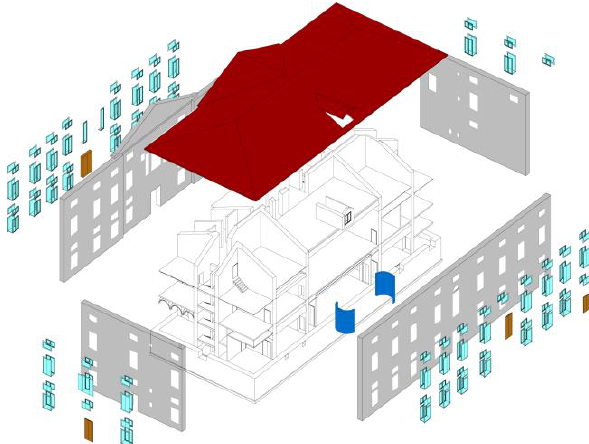
Figure 13. Exploded axonometry of the final parametric model realized for the Palazzo Sarmatoris.